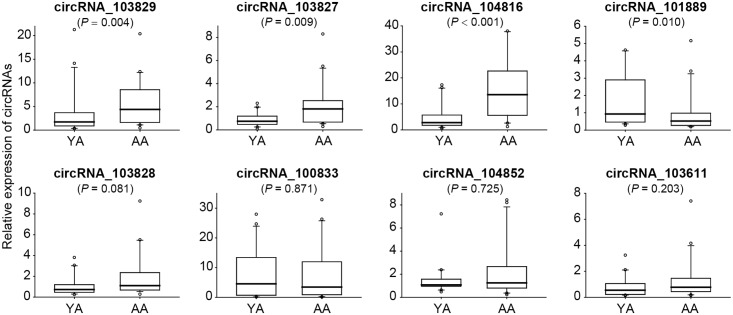
CircRNA expression variations in granulosa cells during maternal aging were validated by qRT-PCR.Comparison of candidate circRNAs (circRNA_103829, circRNA_10827, circRNA_104816, circRNA_101889, circRNA_103828, circRNA_100833, circRNA_104852, circRNA_103611) expression levels in granulosa cells from additional young (n = 20) and older (n = 20) women by qRT-PCR. YA, women with young age (≤ 30 years); AA, women with advanced age (≥ 38 years). P values were calculated by Mann-Whitney U test. Relative expressions were analyzed by 2-ΔΔCt method which was normalized to GAPDH. For each box plotting, the central mark represents the median, the edges of the box represent the 25th and 75th percentiles, and the whiskers are the most extreme data points not considered outliers.